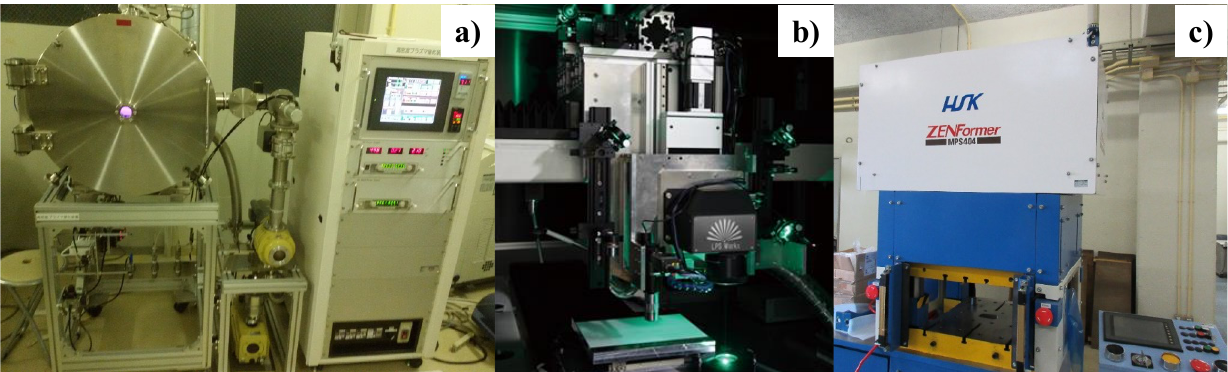
Figure 5. Three systems for tooling and imprinting procedures. ( a ) Low-temperature plasma nitriding system to form the thick hard layer onto the SKD11 punch, ( b ) femtosecond laser machining system to print the micro-/nano-textures into the hardened layer, and ( c ) CNC-stamping system for imprinting these textures onto the product surfaces.